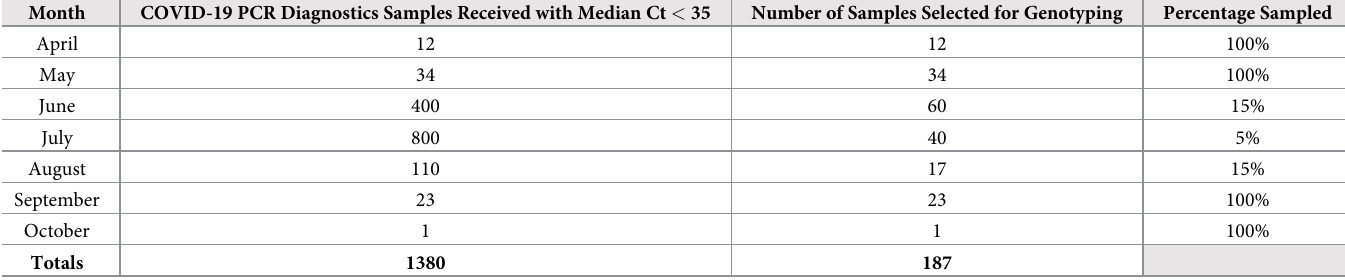
Table 1. Number of samples received for COVID PCR diagnostics during the study period and percentage randomly selected for genotyping. For months with < 50 samples, all samples were selected for genotyping; for months with > 50 but less than < 500 samples, 15% were randomly sampled and for months with > 500 samples, 5% were randomly